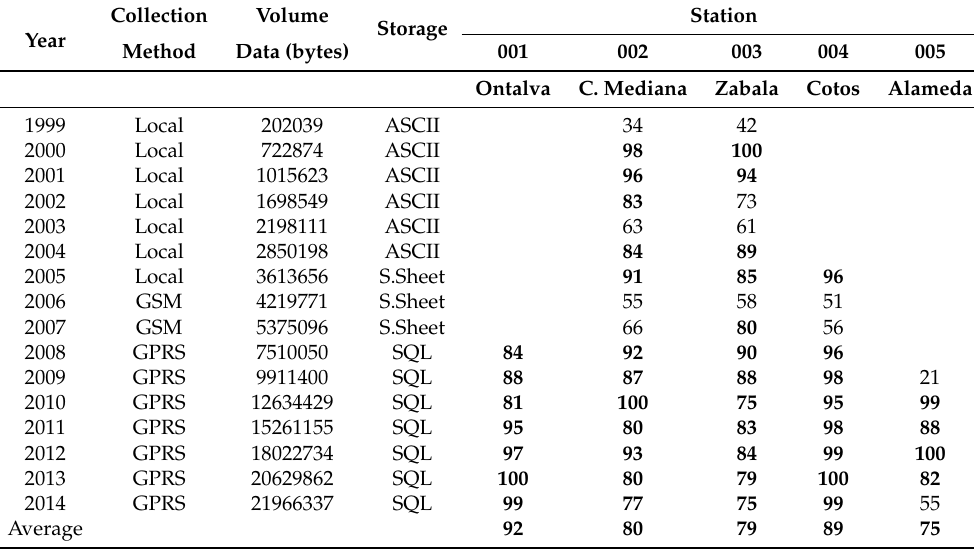
Table 1. Annual average of data completeness of the stations based on availability of air temperature observations (Bold for completeness ≥ 75% and white for not fully operative). Collection method are Local that stands for in situ downloading of data, GSM for analog GSM data collection using modem and GPRS for GPRS TCP/IP protocol using dynamic IPs. Regarding Storage, ASCII stands for individual raw files from data logger, S.Sheet stands for spread sheets for every variable organized in years with individual validation code and SQL stands for PosgreSQL database